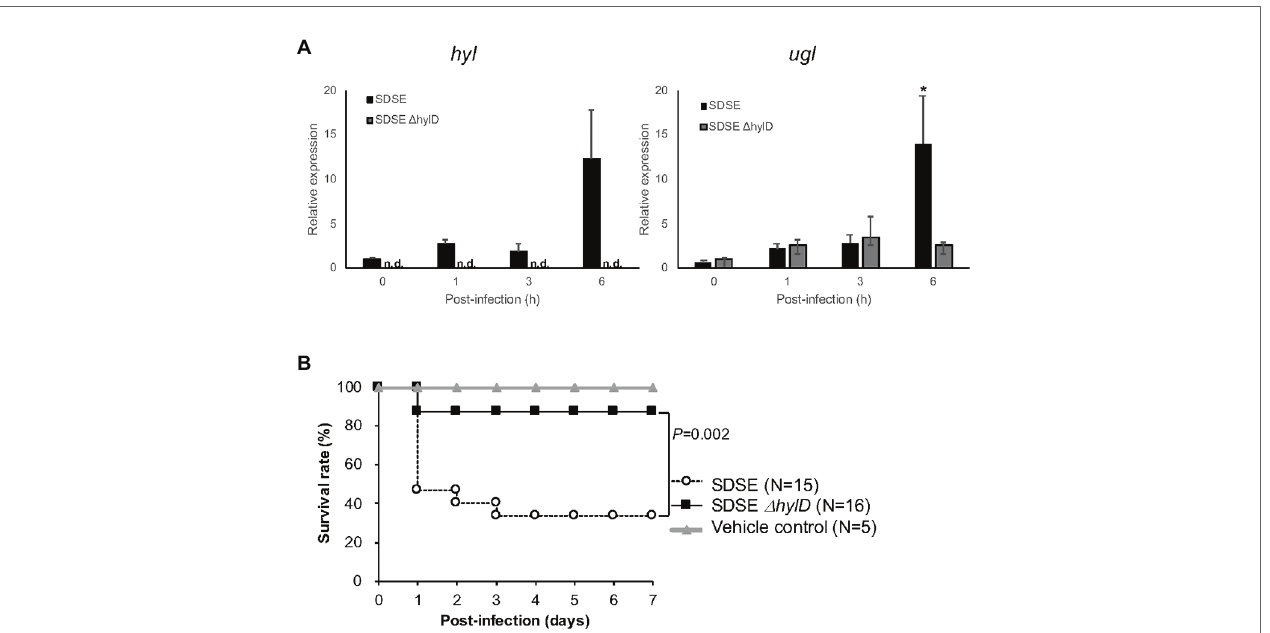
FIGURE 5 | Impact of hylD gene deletion on SDSE infection in mice. (A) The relative expression of hylD and ugl after intraperitoneal injection and recovery. SDSE-124 and SDSE-124 Δ hylD were injected intraperitoneally and collected at the indicated times; * p < 0.01 according to Student’s t -test. Relative expression levels were calculated as 1 using the averages of hyl and ugl expression in SDSE-124 at 0 h. (B) Lethal responses to SDSE-124 and SDSE-124 Δ hylD . SDSE-124 and SDSE-124 Δ hylD were injected intraperitoneally at 2.0 × 10 6 CFU/mouse, and survival was monitored for 7 days. The value of p was calculated using the log- rank test. BHI medium was injected for vehicle control.